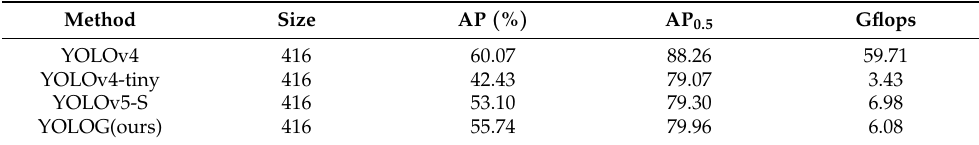
Table 5. The results of different models on the PASCAL VOC 07+12.